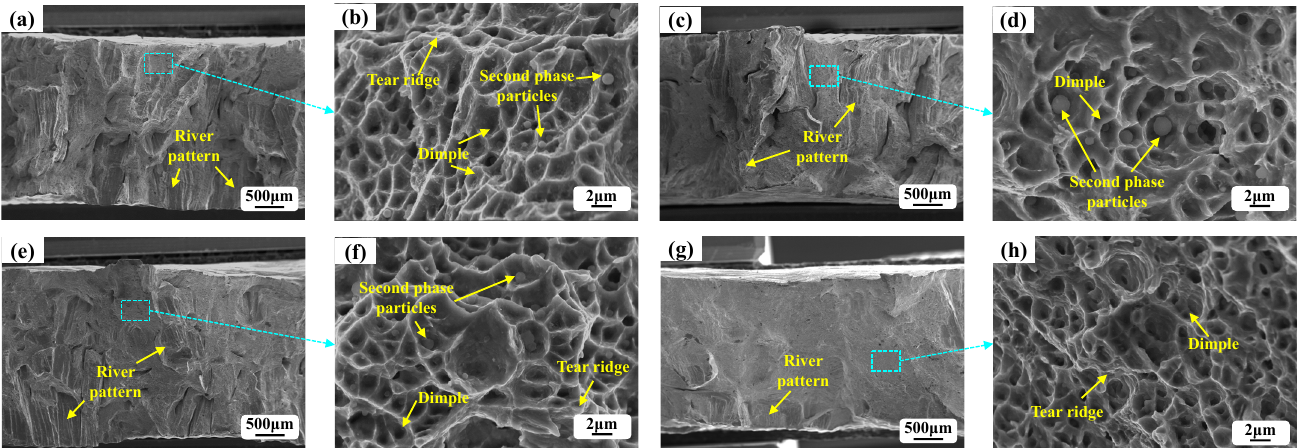
Figure 9. Fracture morphologies of the 316L samples after tensile tests: ( a ) without vibration in low magnifications; ( b ) without vibration in high magnifications; ( c ) with 1D vibration in low magnifi- cations; ( d ) with 1D vibration in high magnifications; ( e ) with 2D vibration in low magnifications; ( f ) with 2D vibration in high magnifications; ( g ) with 3D vibration in low magnifications; ( h ) with 3D vibration in high magnifications.